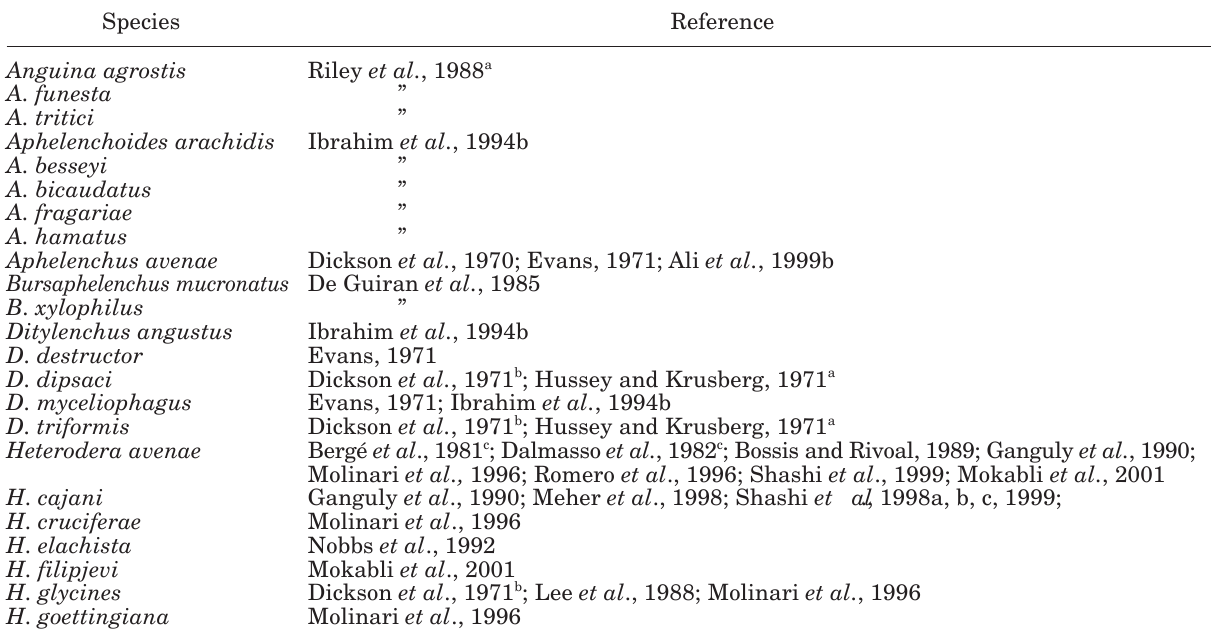
Table 3. Plant-parasitic nematode species characterized on the basis of isozymes, using one-dimensional native gel electrophoresis.